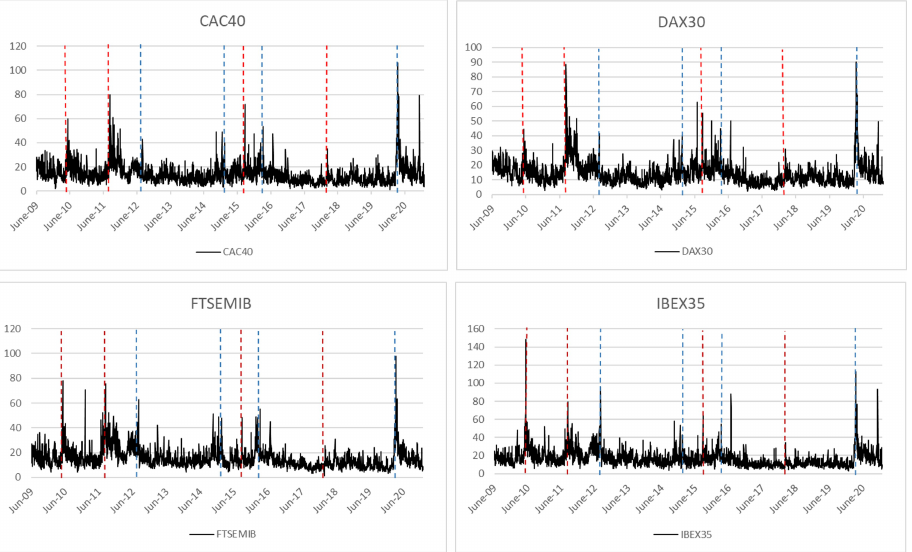
Figure 1. CAC40, DAX30, FTSEMIB and IBEX35 Realized Volatility. Sample period: 1 June 2009 to 31 December 2020. The vertical lines represent relevant events (see the text) causing spikes in the RV S & P 500 (red dashed lines) and ECB monetary policy announcement days (blue dashed